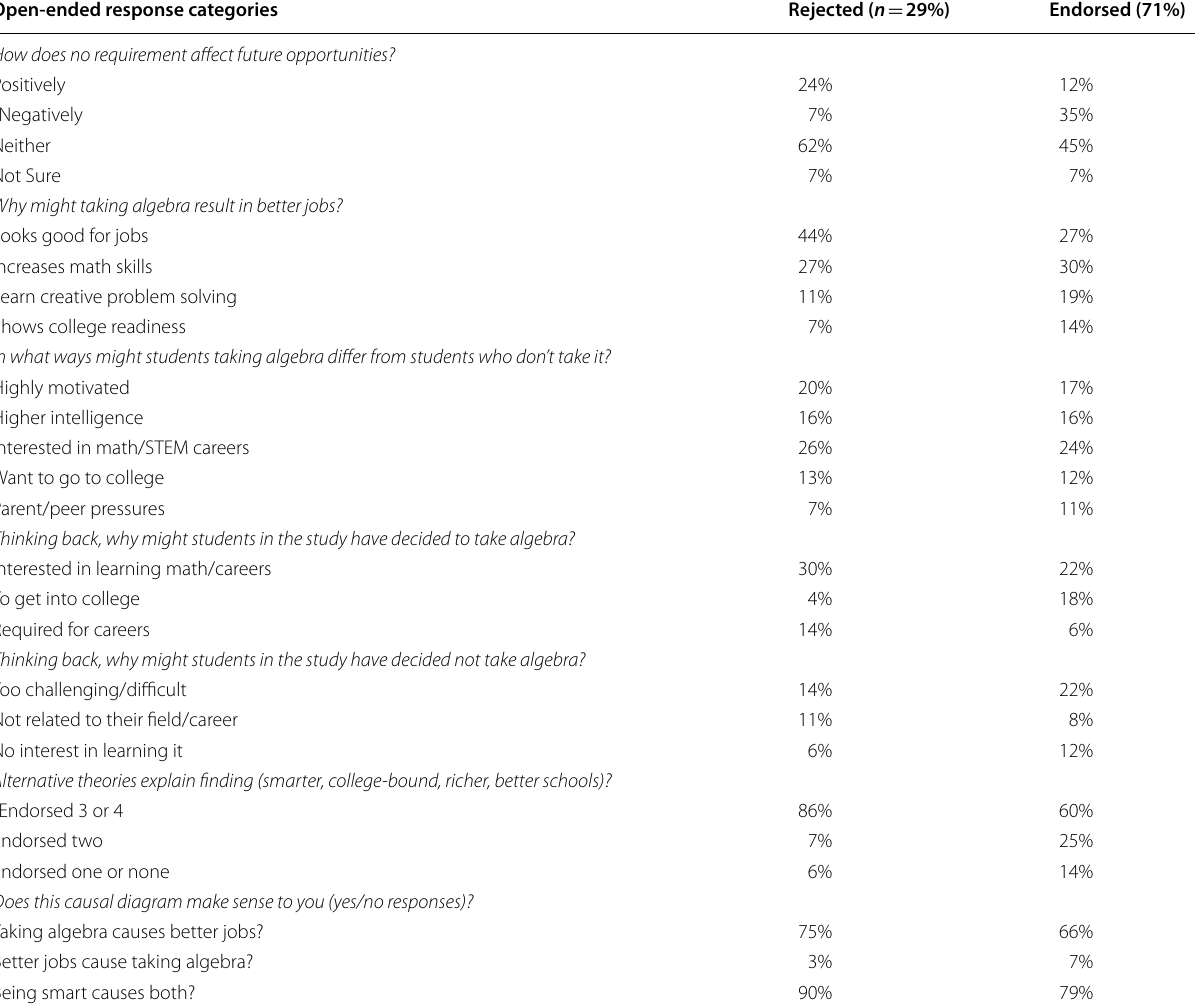
Table 1 Intervention response frequencies for students rejecting versus endorsing causal